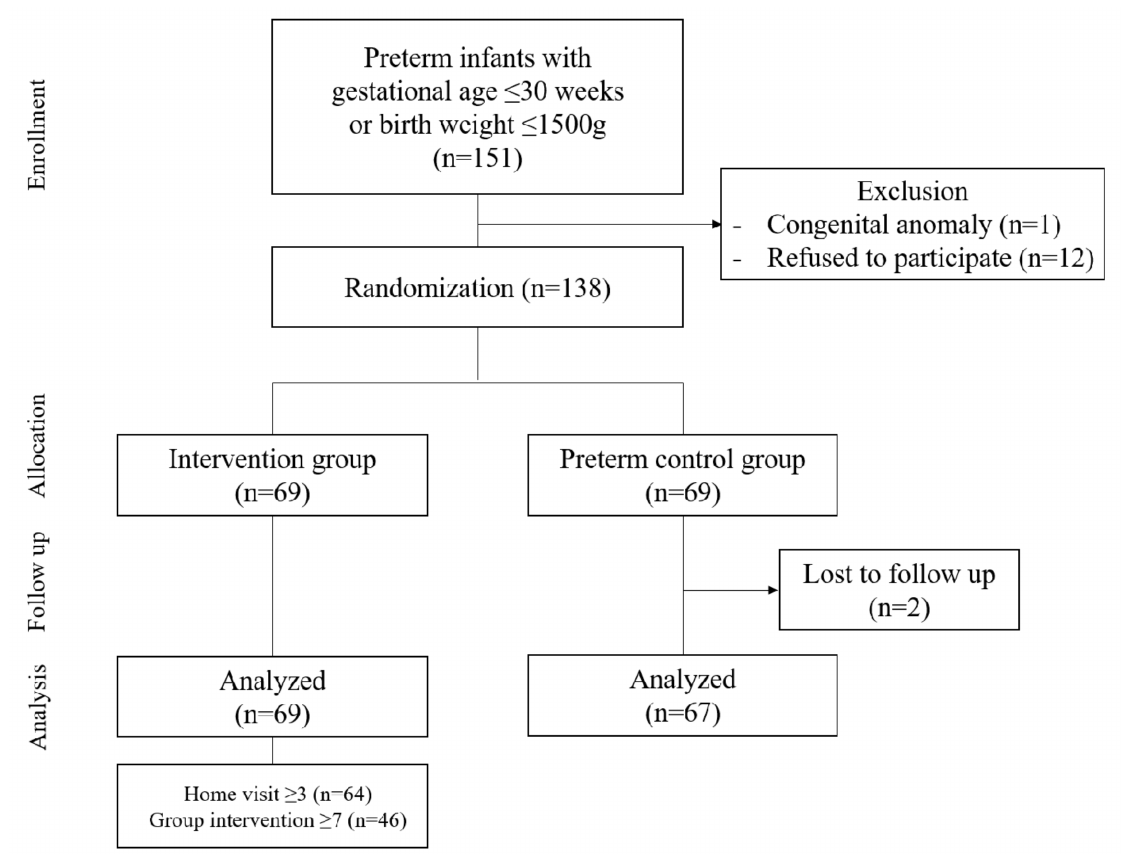
Figure 1. The CONSORT flow study